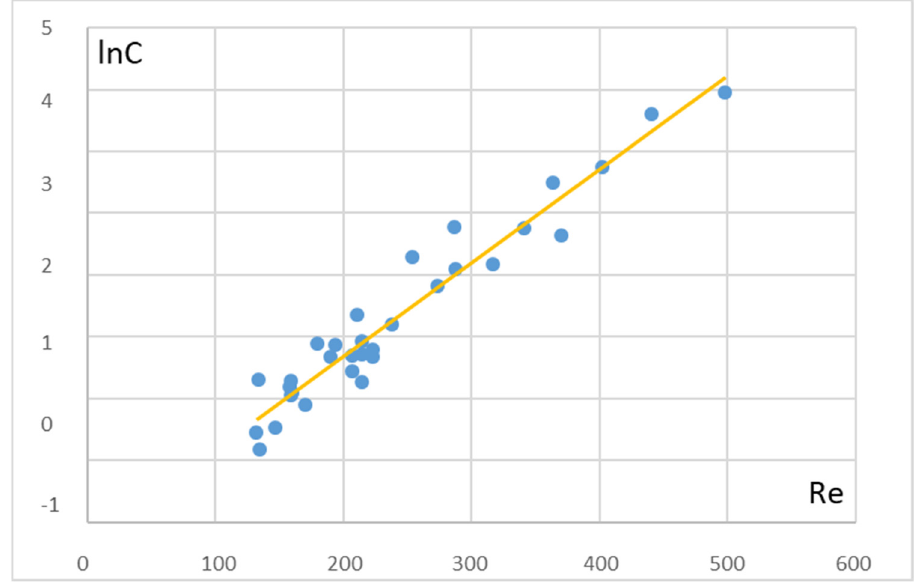
Figure 9. The dependence of ln C on Re for the case Ri > Ri ∗